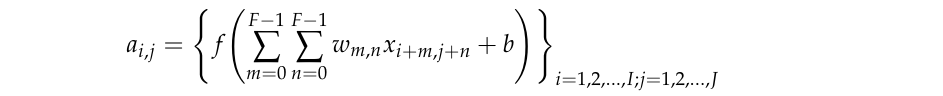
Figure 4. The LeNet-5 structure proposed by Yann LeCun [13].